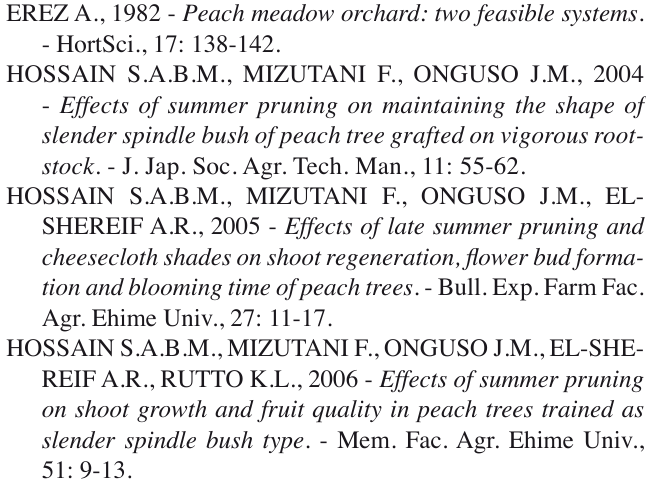
Fig. 15 - Effect of late summer pruning and shading on flower bud formation of peach trees. SP=summer pruning; WP= win - ter pruning; WC=white cheesecloth; BC=black cheesecloth. Data are presented as mean ± standard error ( se ).